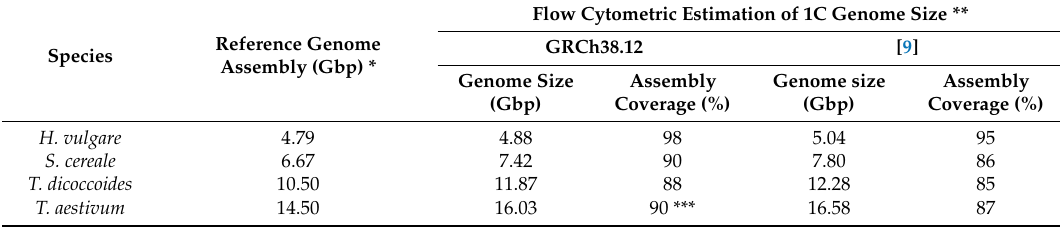
Table 3. The estimated level of completeness of the four Triticeae reference genome assemblies.